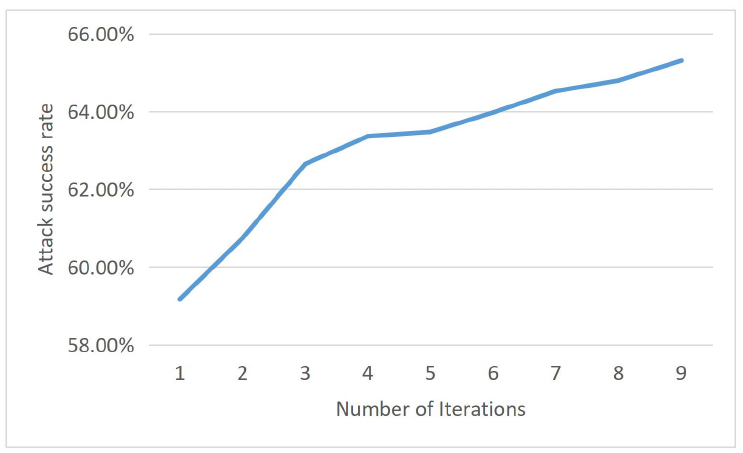
Figure 4. The black-box ASRs of FT-DIM attack with different number of iterations on ImageNet. The adversarial examples are generated on Inc_v3 and the ASRs are the average ASRs on Inc_v4, IncRes_v2, and